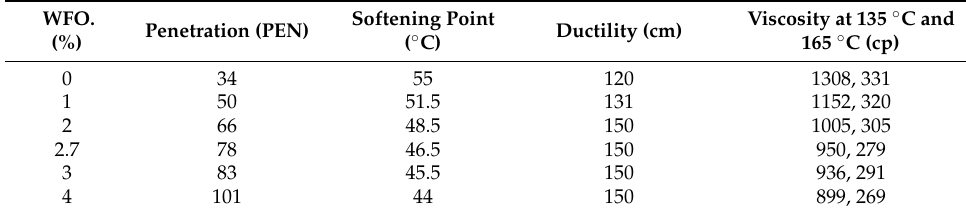
Table 2. Trials to determine the optimum waste frying oil content for the 25% RAPB. WFO. (%)